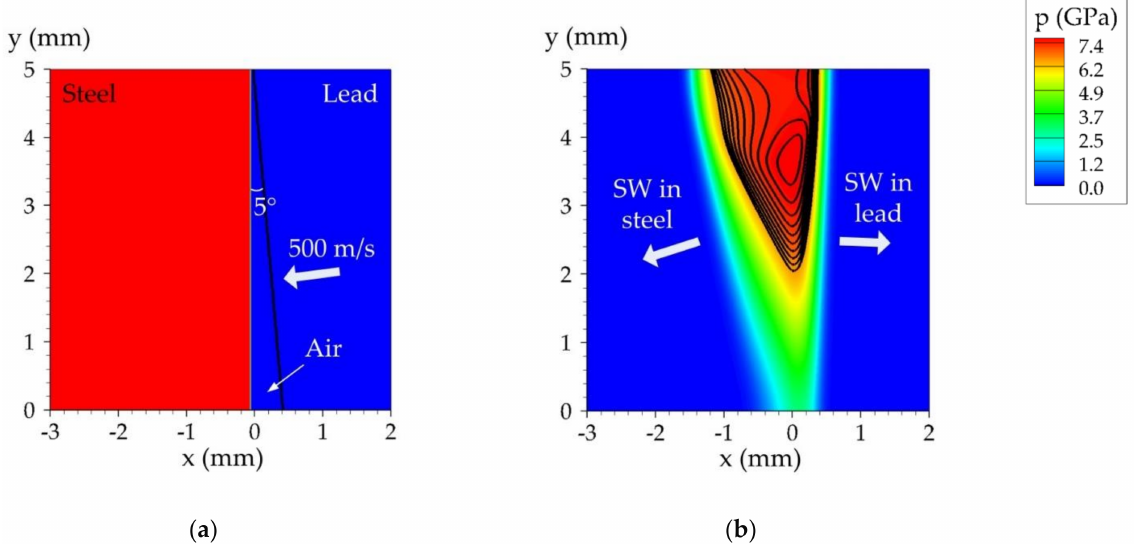
Figure 4. Preliminary two-dimensional simulation of the oblique impact: ( a ) Schematic of the problem; ( b ) predicted spatial distribution of pressure and steel density isolines, time instant 0.3 µ